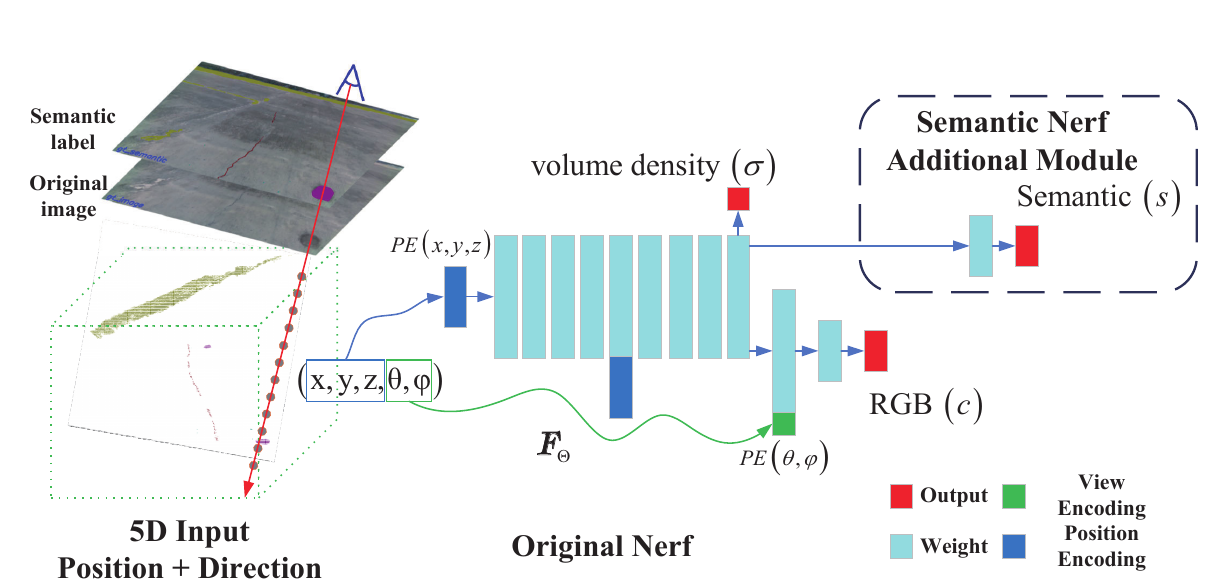
Figure 5. Nerf structure and data flow. Nerf uses 5D (position and direction) vector as the input. Position and direction using different encoding modules. The outputs are density and RGB values.